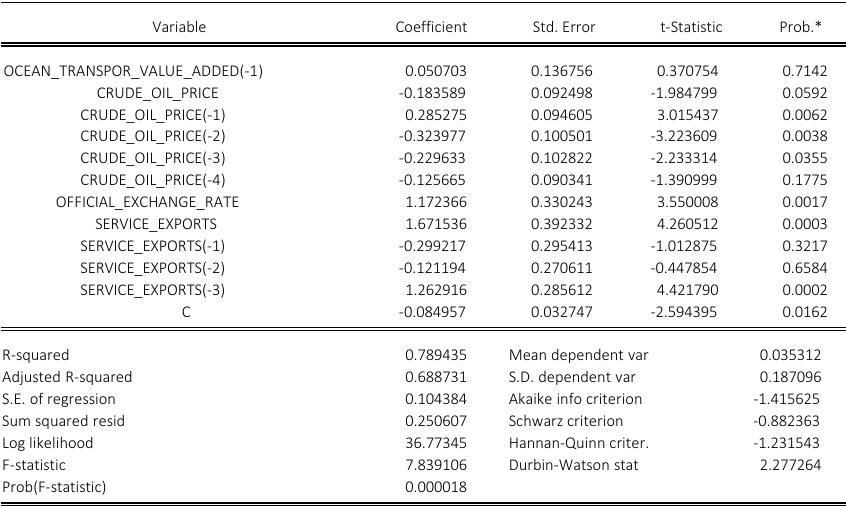
Figure 9. Autoregressive distributed lag (ARDL) testing results in the EViews